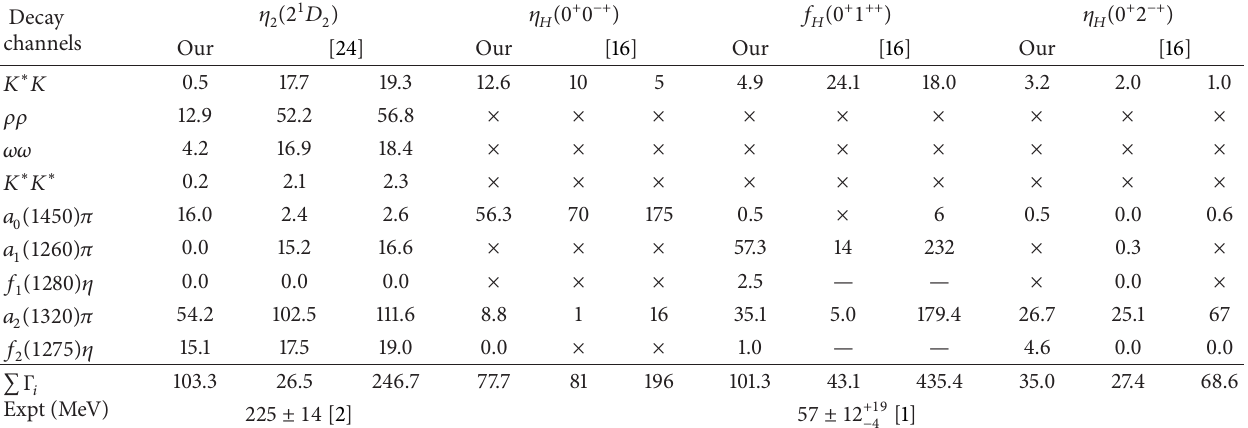
The symbol “ × ” indicates that the decay modes are forbidden and “—” denotes that the decay channels can be ignored. Here, we collected the results given by the 3 𝑃 0 model from [24] in the left column and the right column by the flux-tube model. In [16], the masses are taken as 1.8GeV for the 0 −+ , 1 ++ , and 2 −+ hybrid